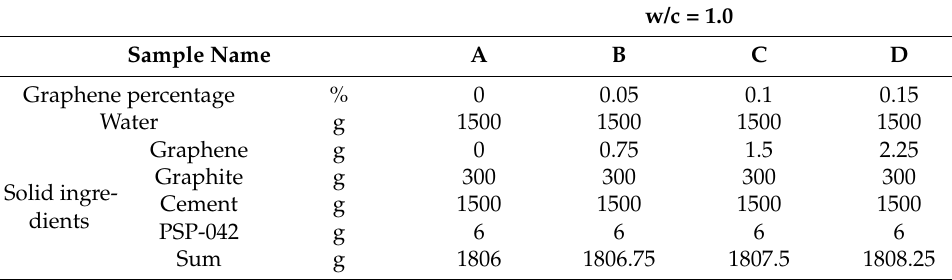
Table 1. The formulas of the individual cement